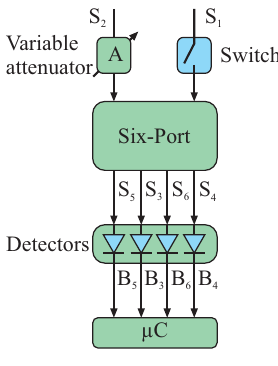
Figure 7. Exemplary circuitry for deriving the characteristics of all diode detectors by switching off one input signal and sweeping the power of the other continuous wave (CW) input